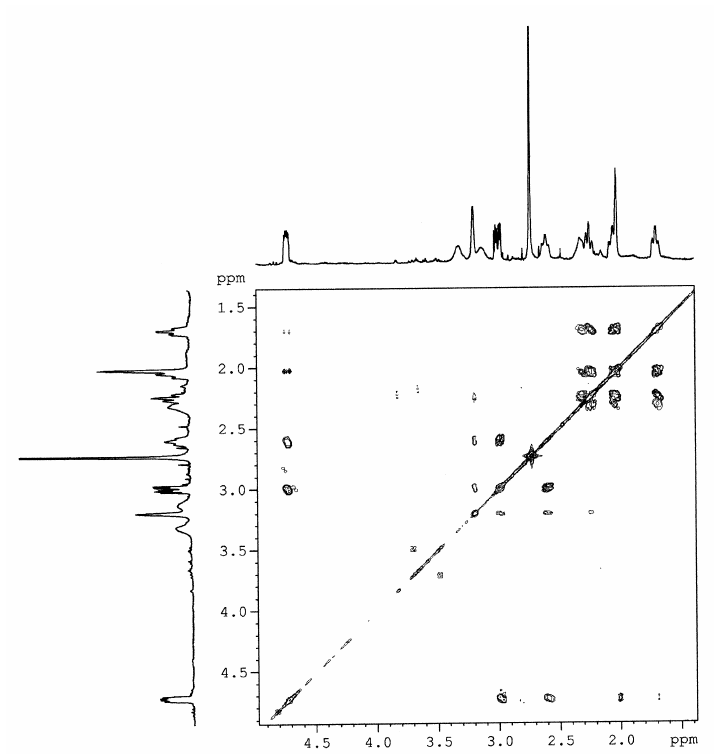
Fig. 6 Section of the COSY-45 spectrum of compound 8